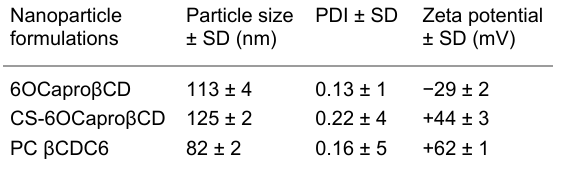
Table 4: Mean particle size, PDI and zeta potential of PCX-loaded nanoparticles (CD amount is 0.5 mg/mL and initial PCX amount is 0.05 mg/mL in all formulations) ( n = 3, ± SD).